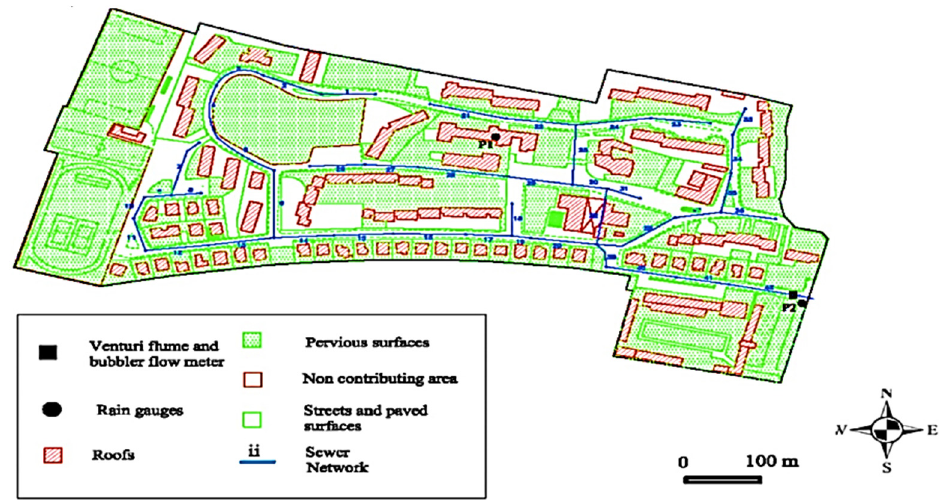
Figure 1. Cascina Scala experimental catchment, Pavia, Italy.